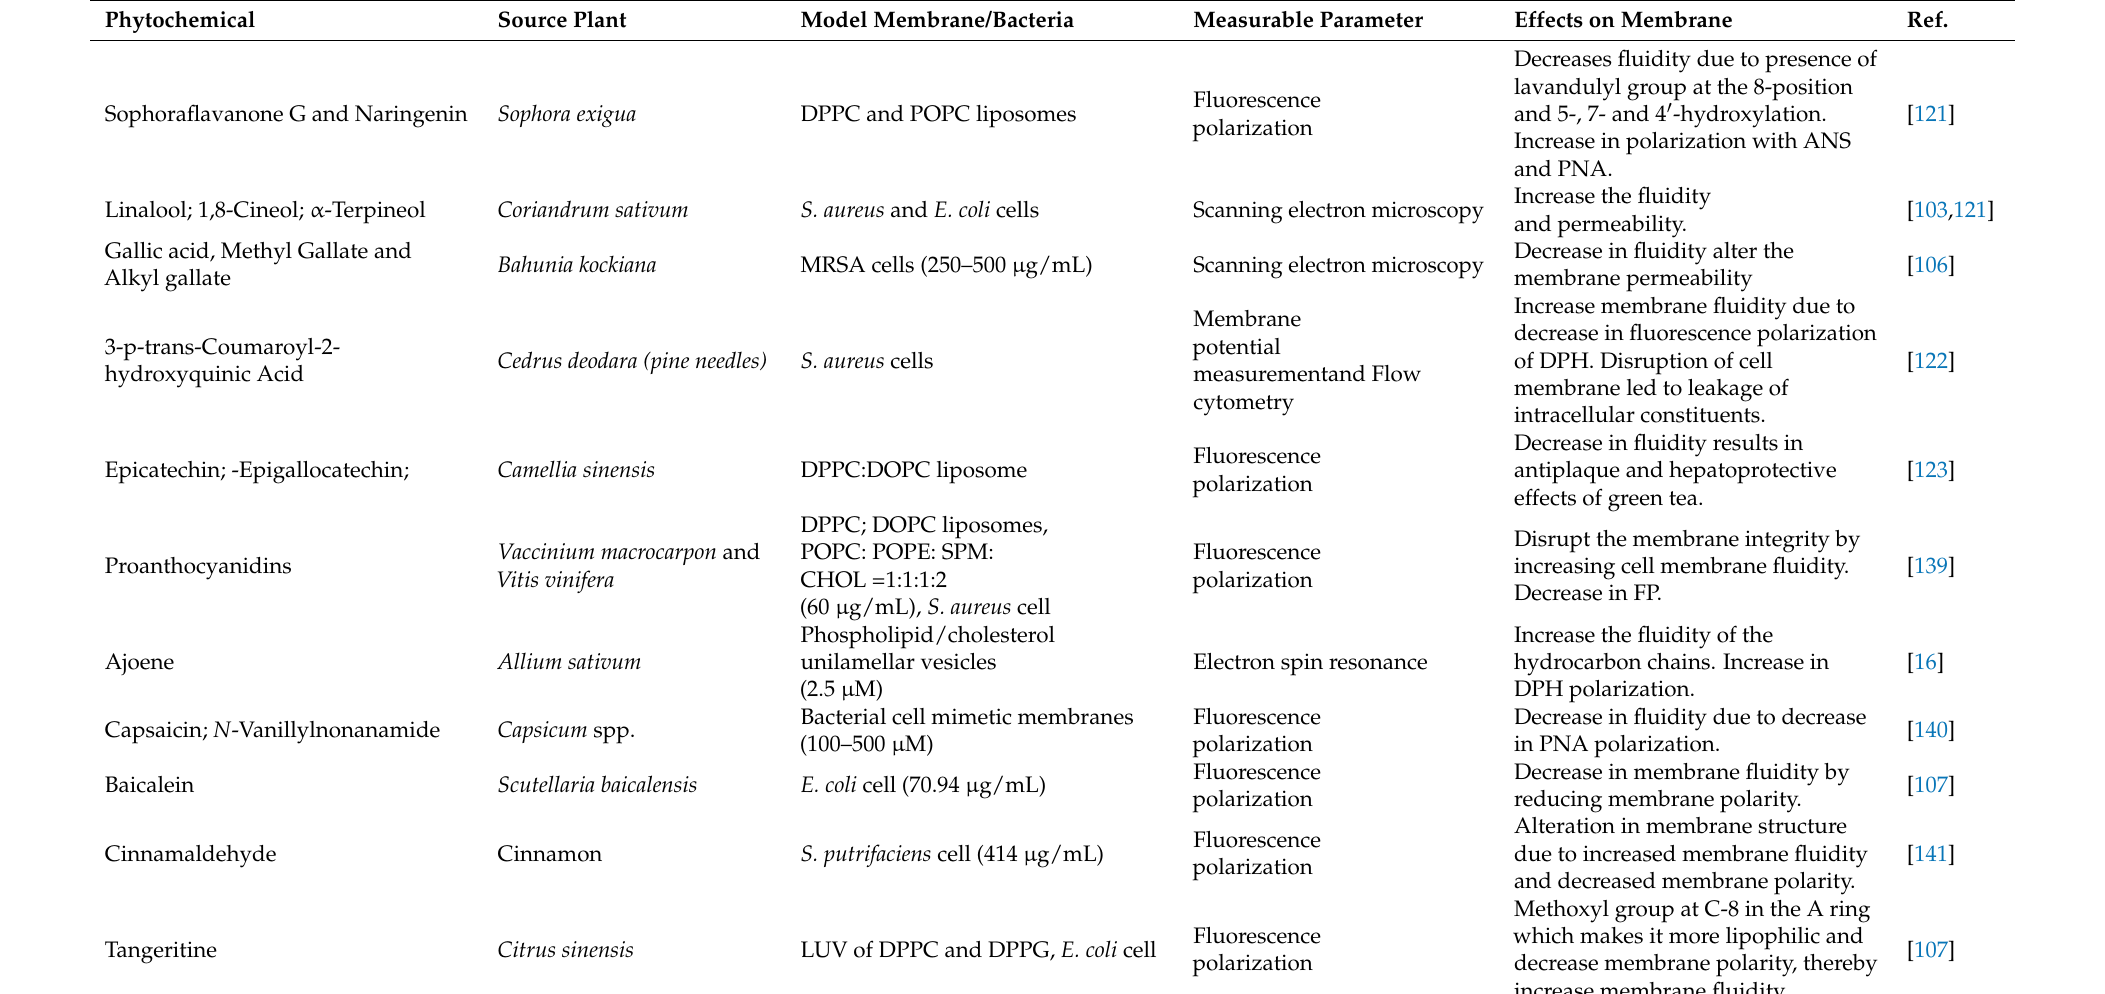
Table 2. Phytochemicals that act through alteration of membrane